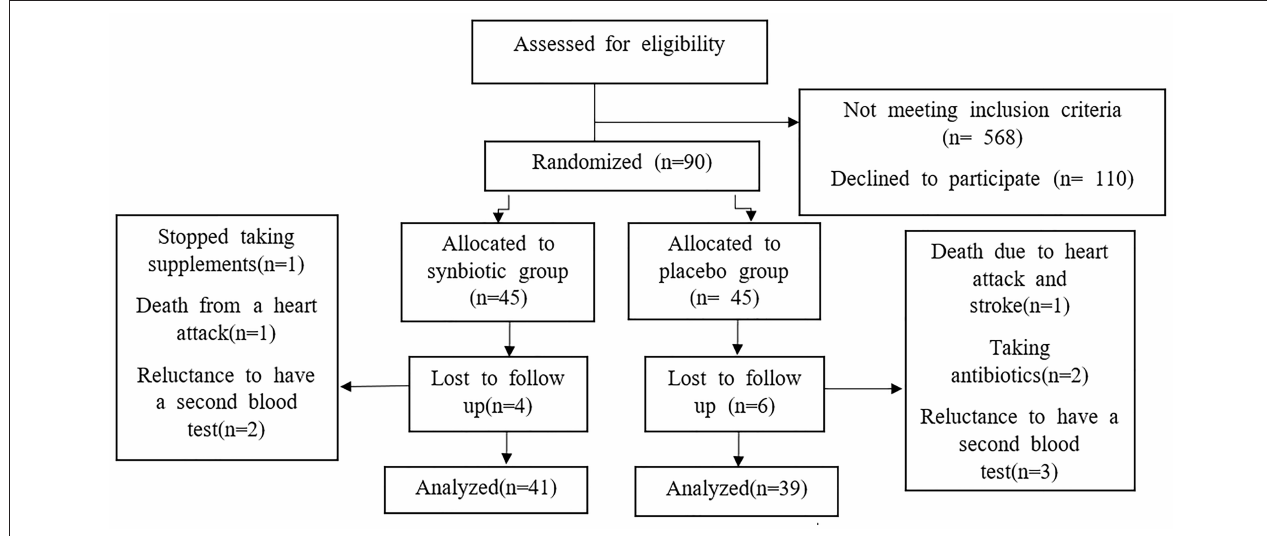
FIGURE 1 | Shows the study consort flow